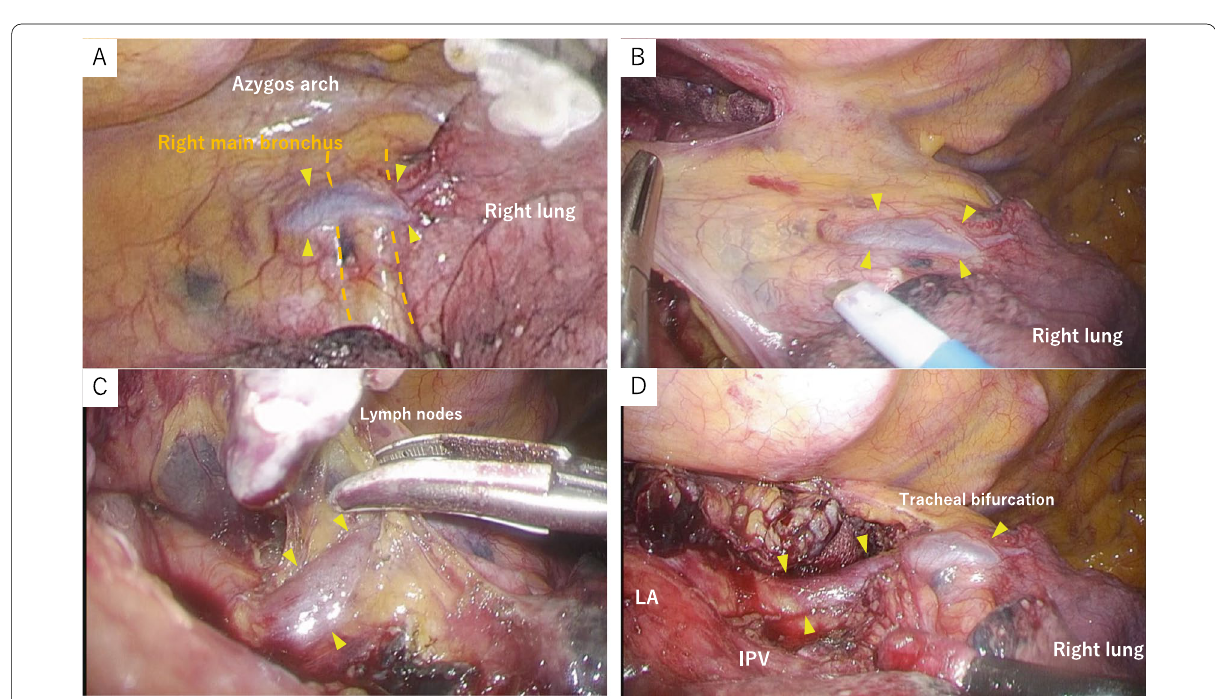
Fig. 3 Operative findings. A – D The lymph nodes at the tracheobronchial bifurcation (#107, #109R, #109 L) were contiguously dissected from the epicardial surface, and the right main bronchus (dotted line) dorsal inflow pulmonary vein (arrowhead) was dissected and preserved. LA left atrium, IPV inferior pulmonary